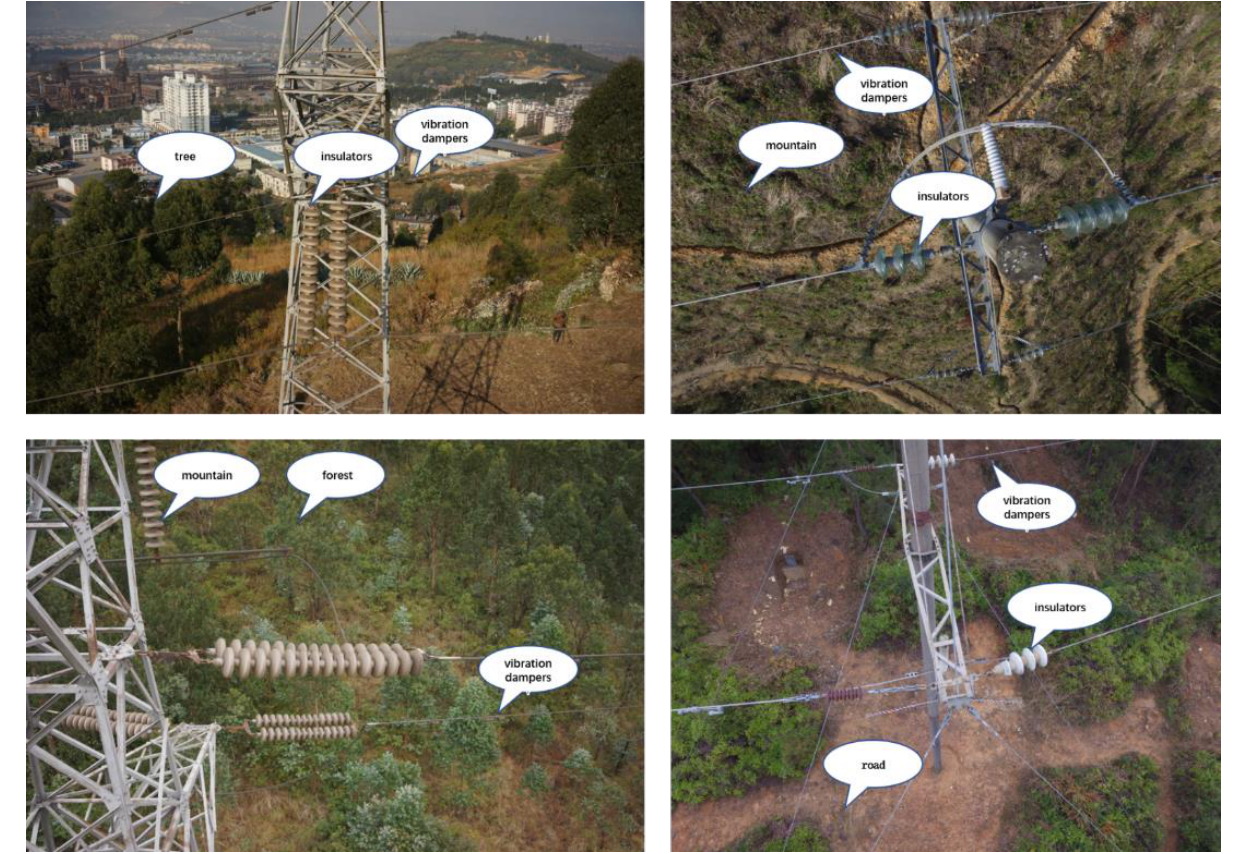
Figure 5. Partial images with vibration dampers and insulators.